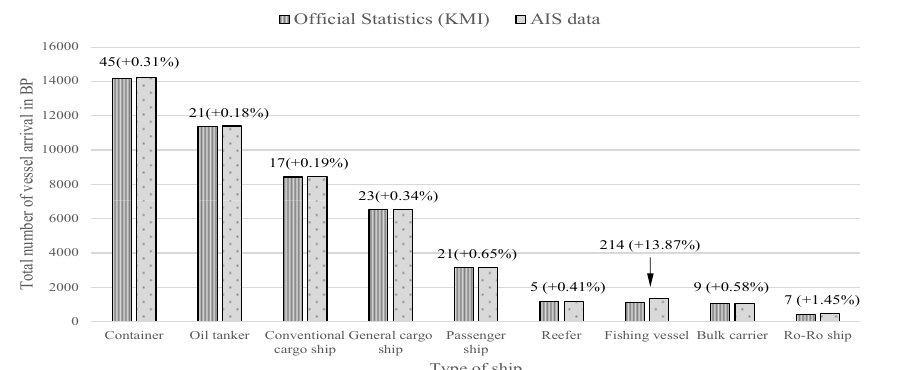
Figure 2. Vessel arrivals of different types between KMI and AIS data in BP in 2019 [38].